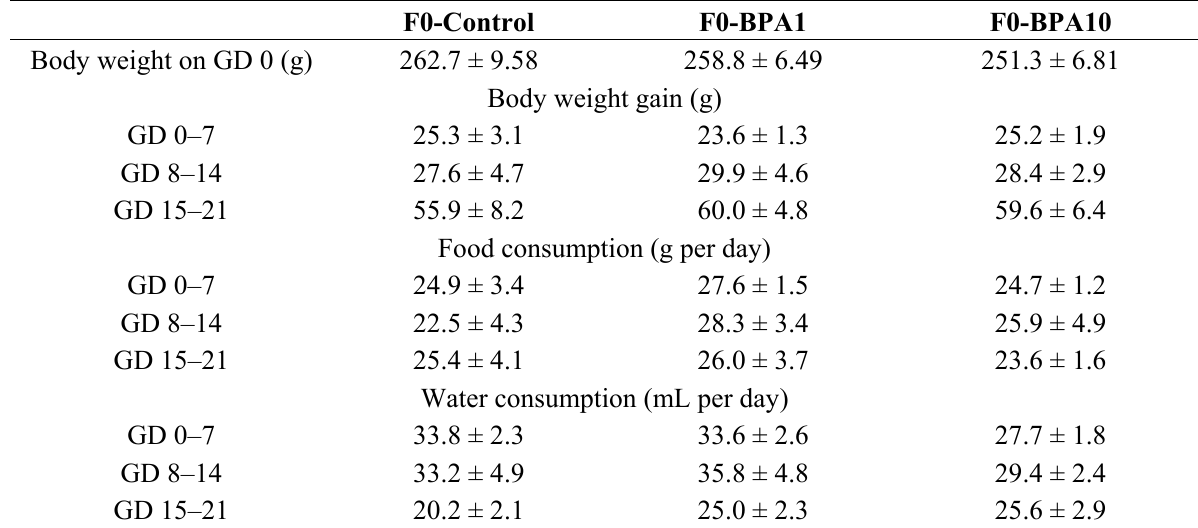
Table 1. Effects of BPA exposure during pregnancy and lactation on maternal physiology. Pregnant rats ( n = 7/group) were exposed to vehicle or BPA in water at levels of 1 or 10 µg/mL from gestation day 6 through the end of lactation. The change of body weight and the amount of food and water intake during pregnancy were measured. Values